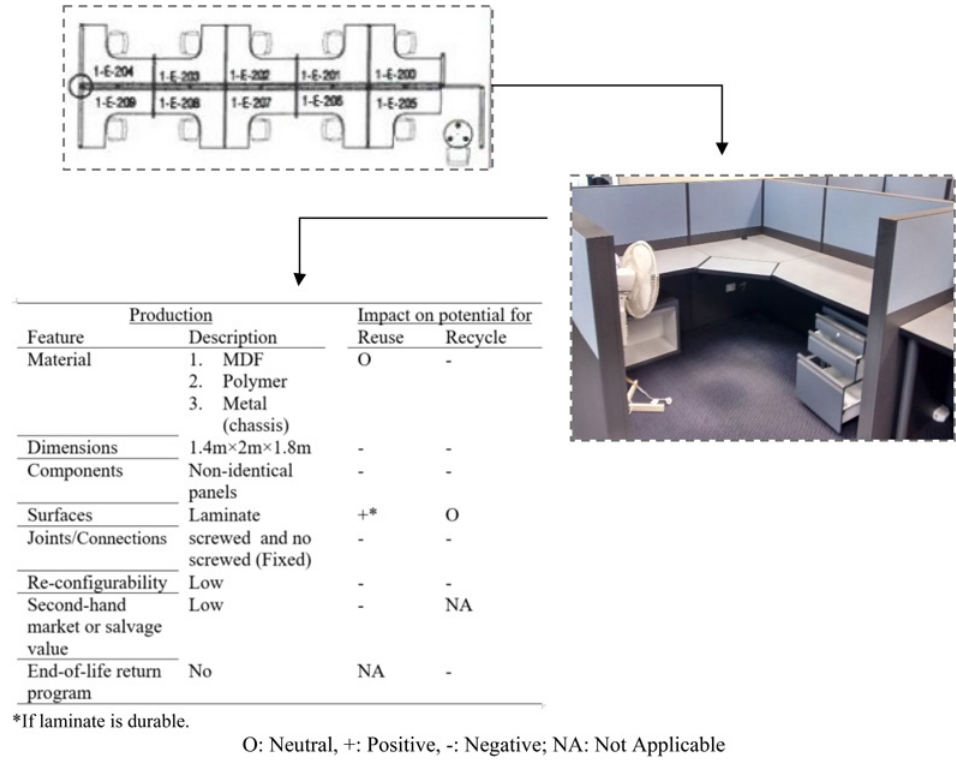
Figure 7 Production features of a workstation and their impact on reusability and